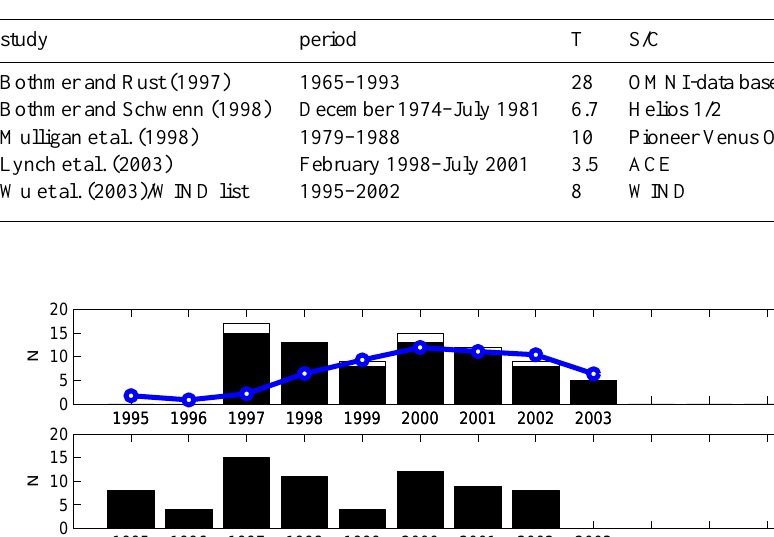
Table 1. Summary of the five previous studies we have compared our statistical results. In Bothmer and Rust (1997) no duty cycle consid- erations are made. In Bothmer and Schwenn (1998) MCs were observed between 0.3–1AU. The Wu et al. (2003) study covered the years 1996–2001. For 1995 and 2002 see the WIND magnetic cloud list.